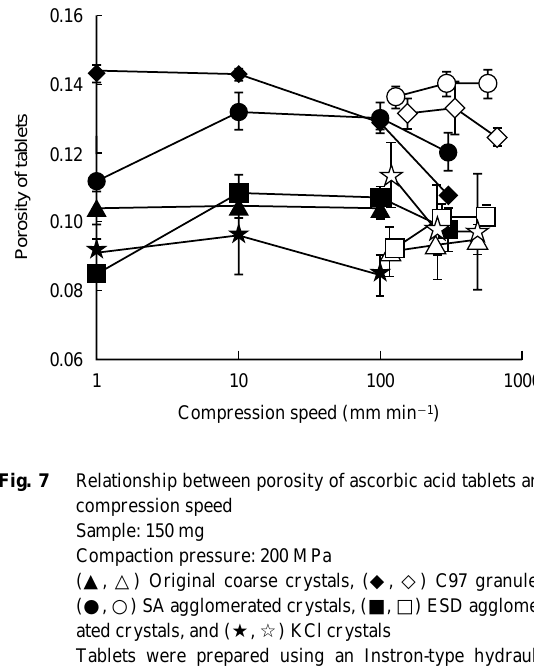
Relationship between porosity of ascorbic acid tablets and compression speed Sample: 150 mg Compaction pressure: 200 MPa ( ▲ , △ ) Original coarse crystals, ( ◆ , ◇ ) C97 granules, ( ● , ○ ) SA agglomerated crystals, ( ■ , □ ) ESD agglomer- ated crystals, and ( ★ , ☆ ) KCl crystals Tablets were prepared using an Instron-type hydraulic press (closed symbols) or single-punch tableting machine (open symbols) at a 200 MPa compaction pressure. The results are expressed as the mean (cid:5) S.D. of four